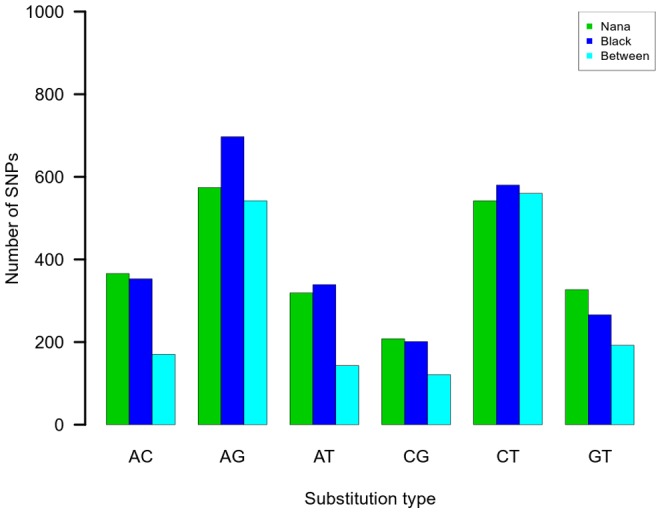
Distribution of SNP substitutions within and between ‘Nana’ and ‘Black’ accessions.The frequency of nucleotide substitutions was counted in ‘Nana’ (green) and ‘Black’ (blue). Where ‘Nana’ was homozygous for one allele and ‘Black’ was homozygous for another, it was counted as a between-accession SNP (turquoise).